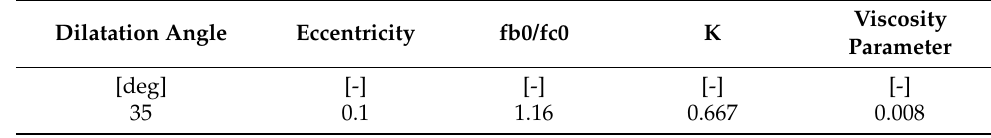
Table 7. Concrete Damaged Plasticity model parameters.